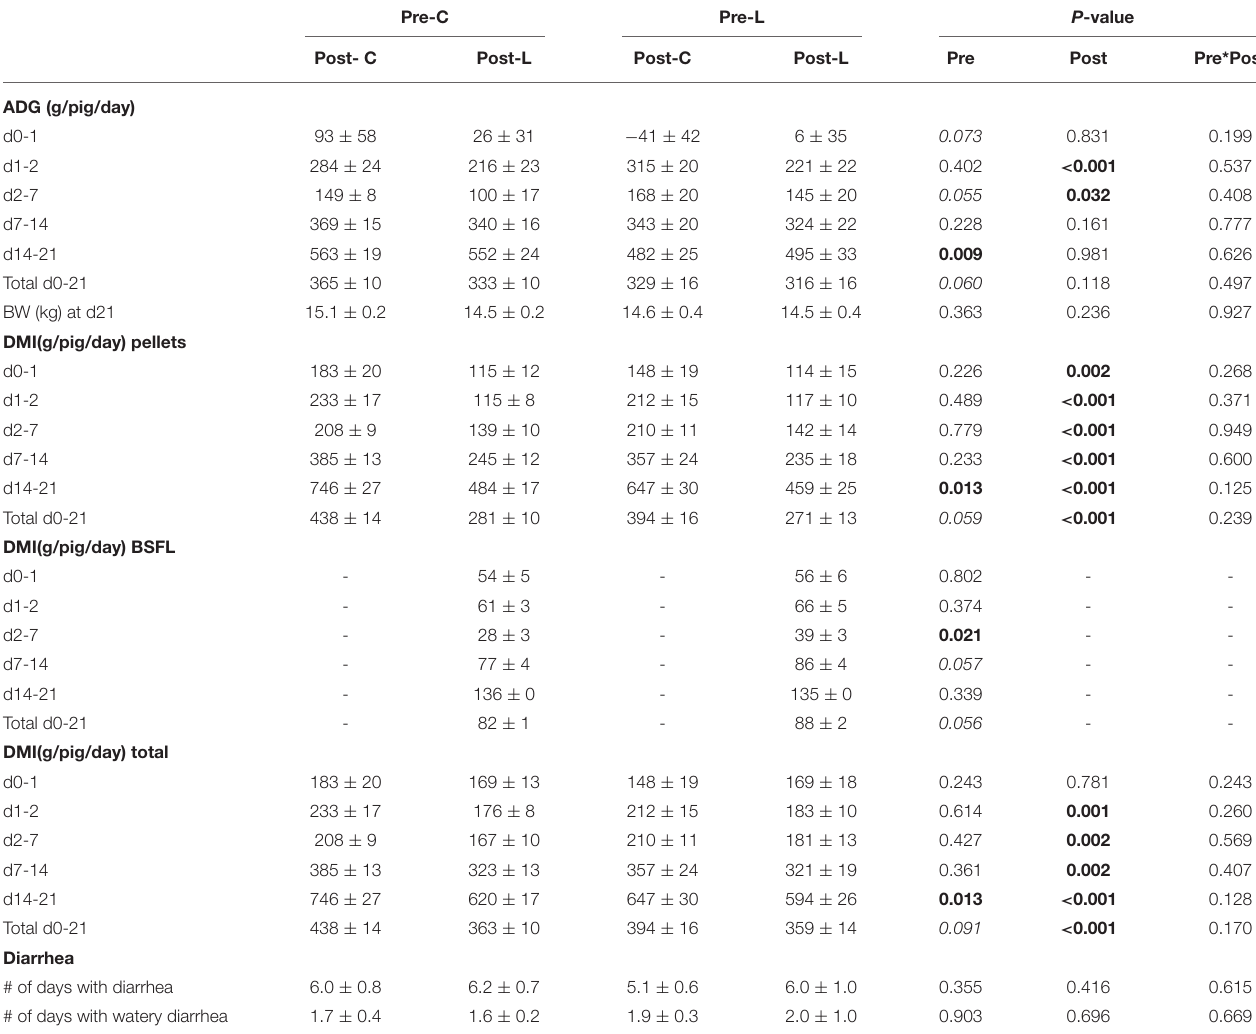
TABLE 6 | Post-weaning piglet average daily gain, feed consumption, and days with (watery) diarrhea. Pre-C Pre-L P -value Post- C Post-L Post-C Post-L Pre Post